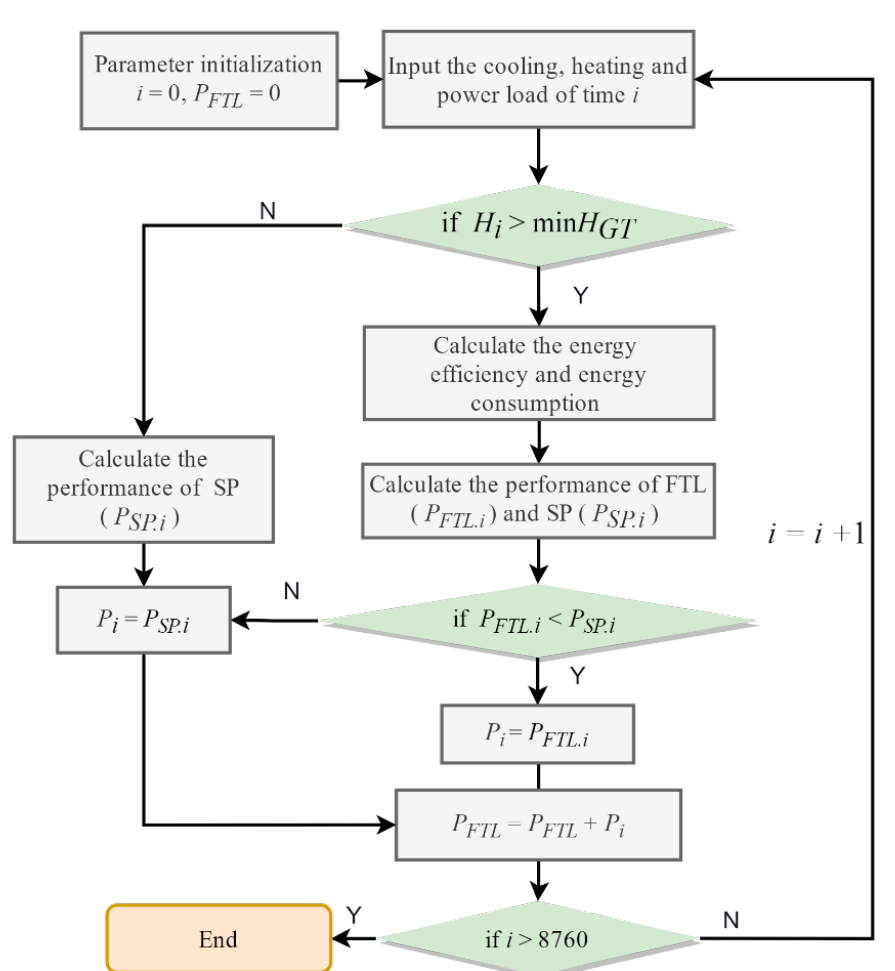
Figure 5. Flowchart of FTL operational strategy.